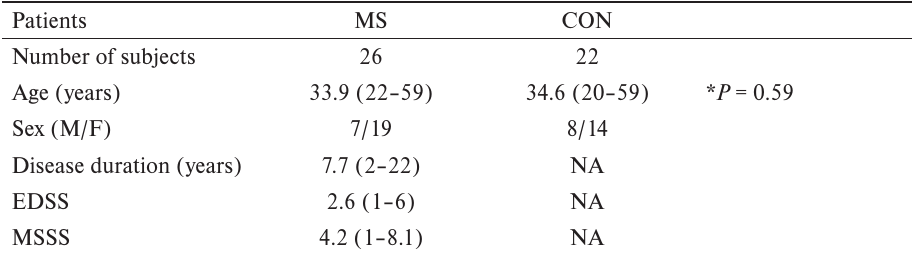
Table 1. Demographic and clinical data of patients with multiple sclerosis and healthy